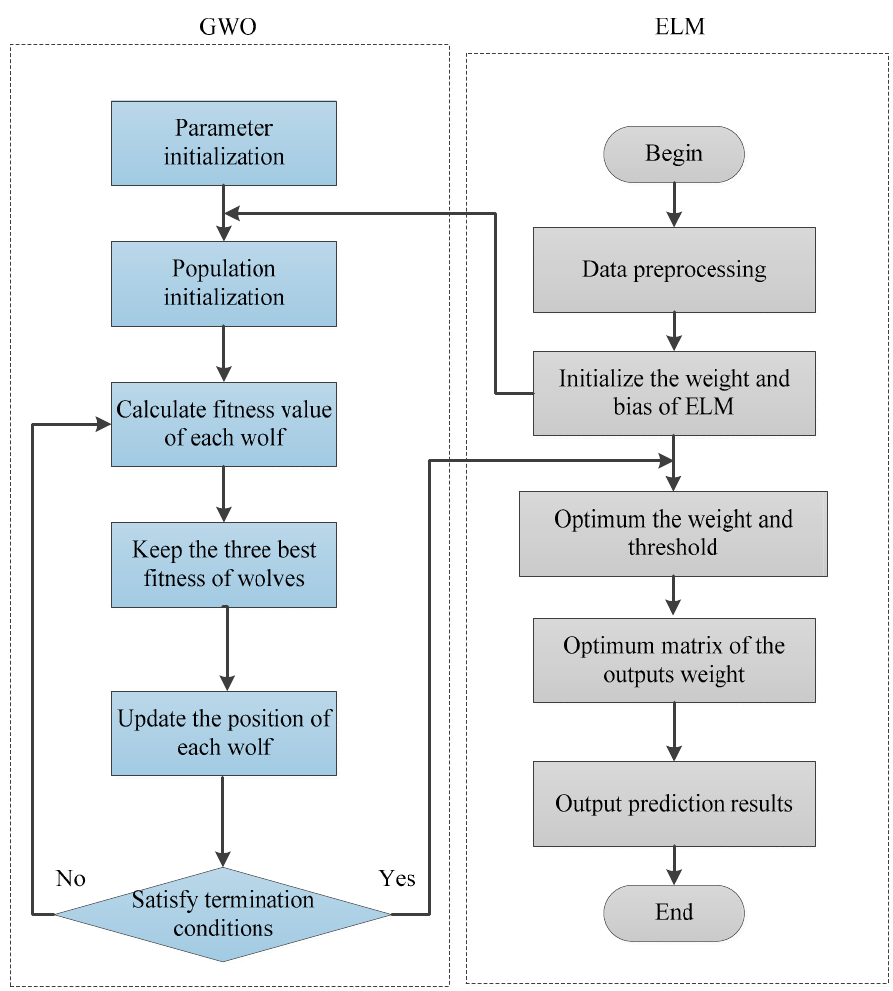
Figure 2. The process of the proposed GWO-ELM model.